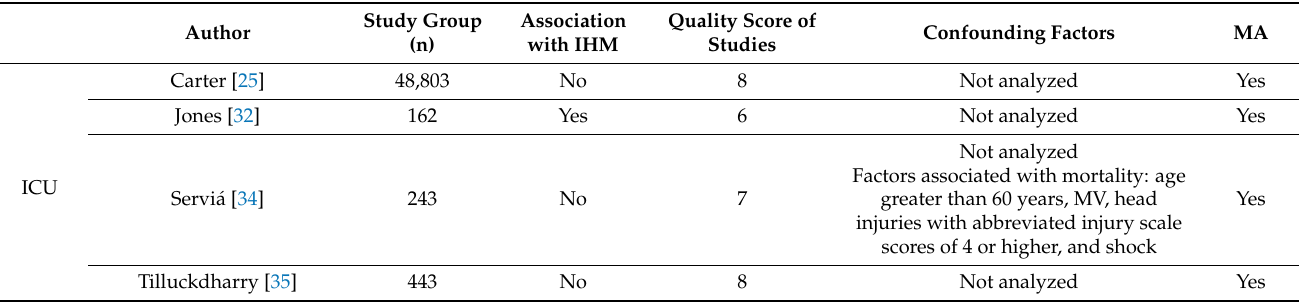
Table 3. Distribution of the studies that showed an association between EDLOS and IHM for each population and quality score of